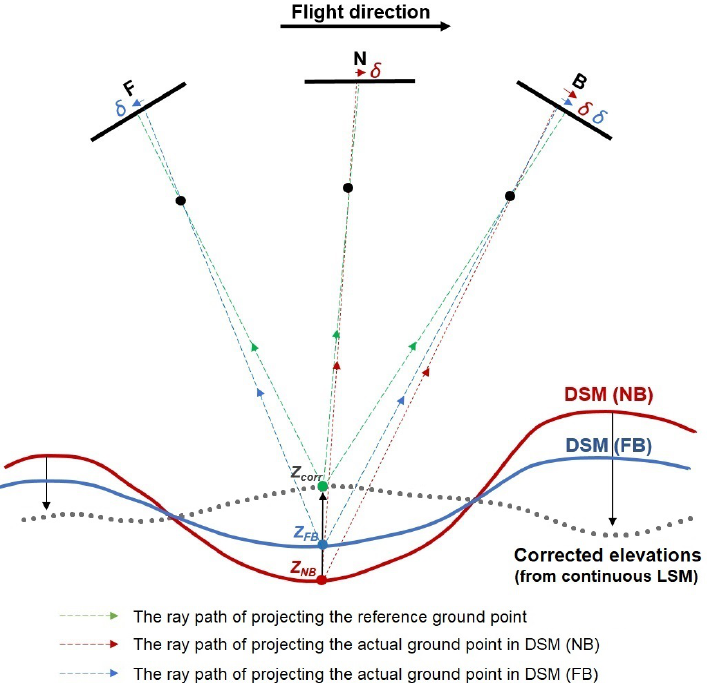
Figure 6. Computation of image